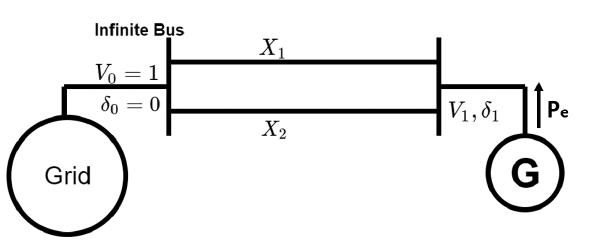
Figure 2. One-machine infinite bus.